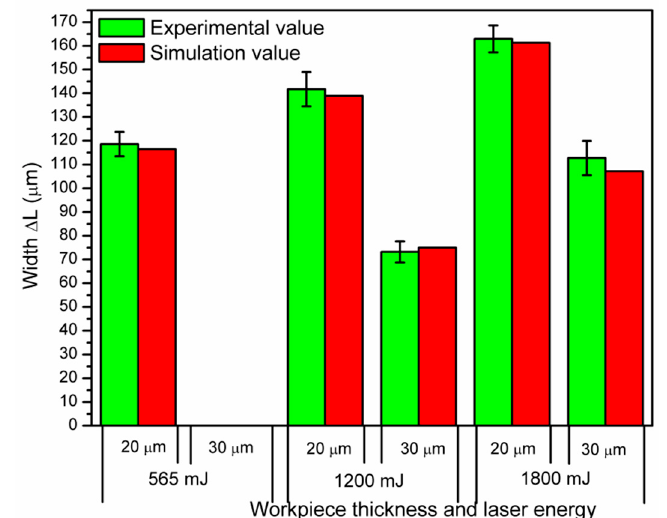
Figure 15. The width of the flat bottom region of the formed parts with different thicknesses and under different laser energy in the experiments and numerical simulation.